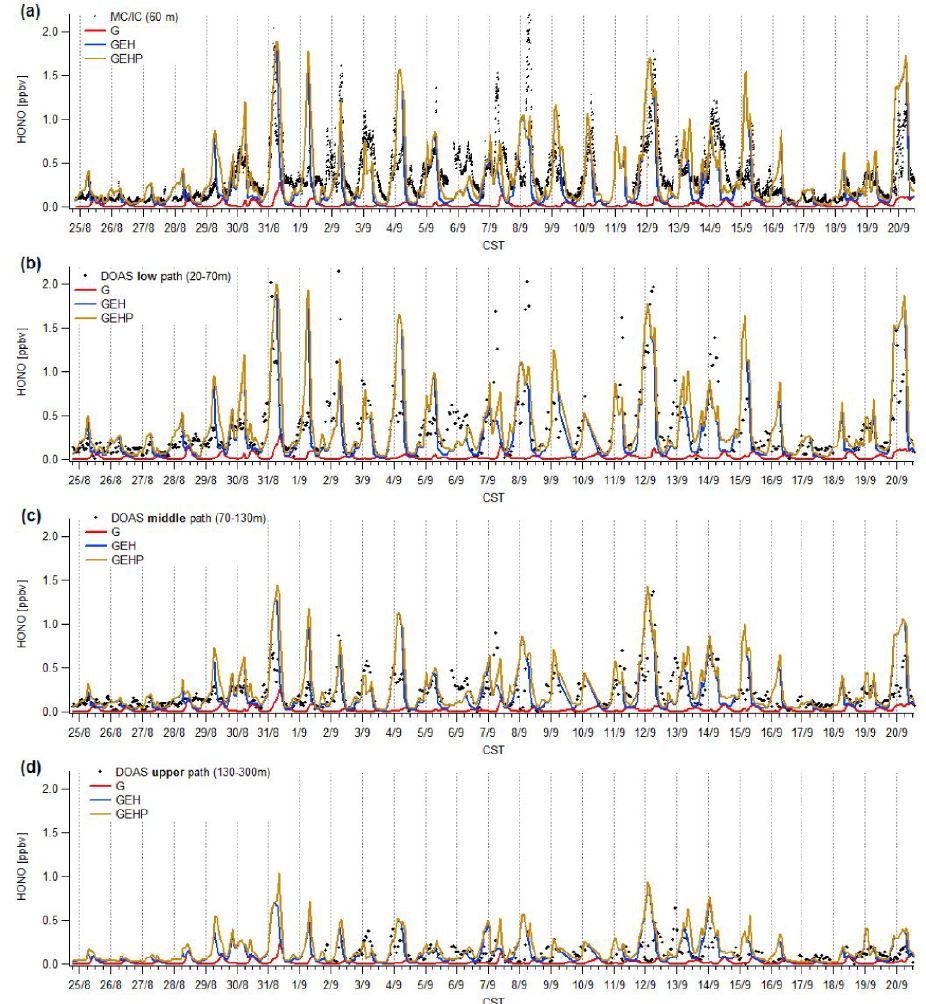
Fig. 1. Comparison of measured vs. simulated HONO time series at the UH Moody Tower for the time period 25 August–20 September 2006. Dots represent measured values, the solid lines represent CMAQ predicted concentration from G, GEH, and GEHP cases (explanation see text). Dashed vertical lines indicate midnight times. (a) : Comparison with data measured in-situ by a MC/IC system at the top of the Moody Tower, at 60ma.g.l. (b–d) : Time series comparison of HONO measured from the Moody Tower by DOAS low light-path (b) , middle light path (c) , and upper path (d)